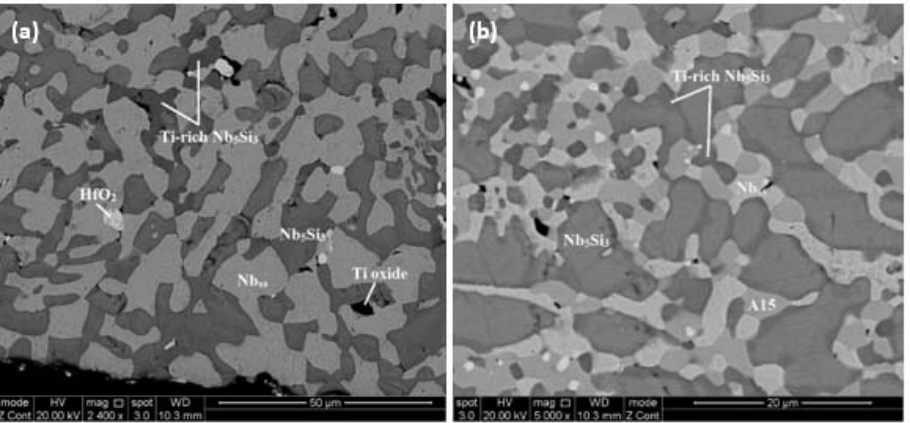
Figure 3. BSE images of the microstructures of the heat ‐ treated alloys ( a ) JZ1 and ( b ) JZ2. The average composition of the alloy after the heat treatment (JZ2 ‐ HT) was 51Nb ‐ 12Ti ‐ 21.1Si ‐ 5.4Ta ‐ 2.1W ‐ 0.8Hf ‐ 2.7Sn ‐ 4.9Ge. Chemical inhomogeneity of Si was still present. The